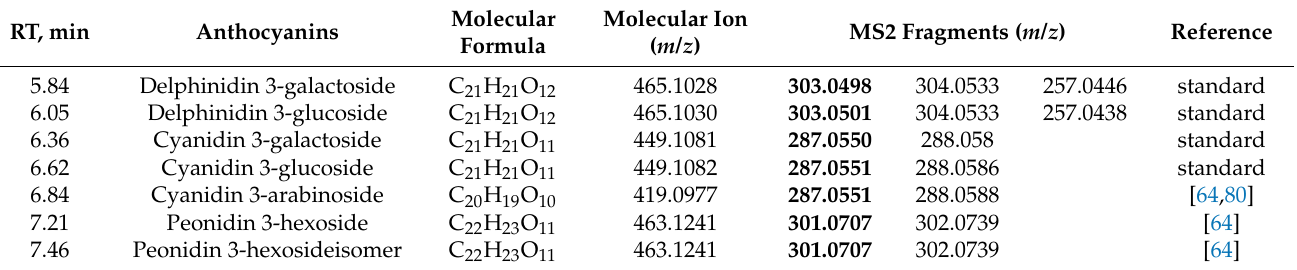
Table 6. High resolution accurate mass data of the identified anthocyanins in positive mode.